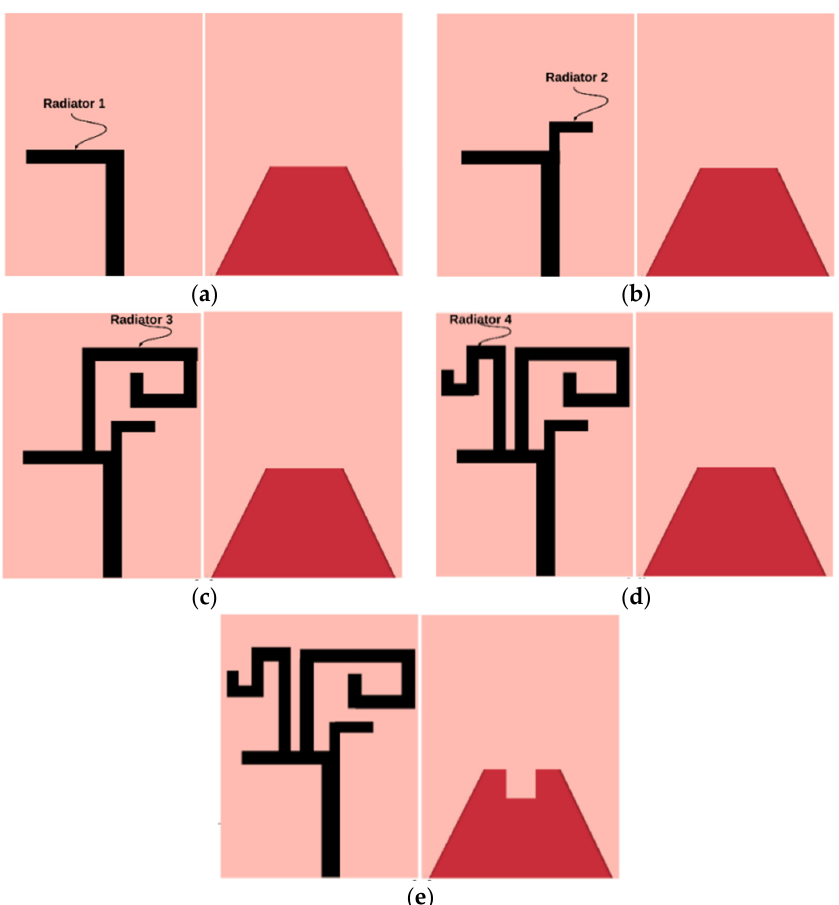
Figure 2. Development of the quad-band antenna element ( a ) antenna-1, ( b ) antenna-2, ( c ) antenna-3, ( d ) antenna-4, ( e ) proposed antenna.